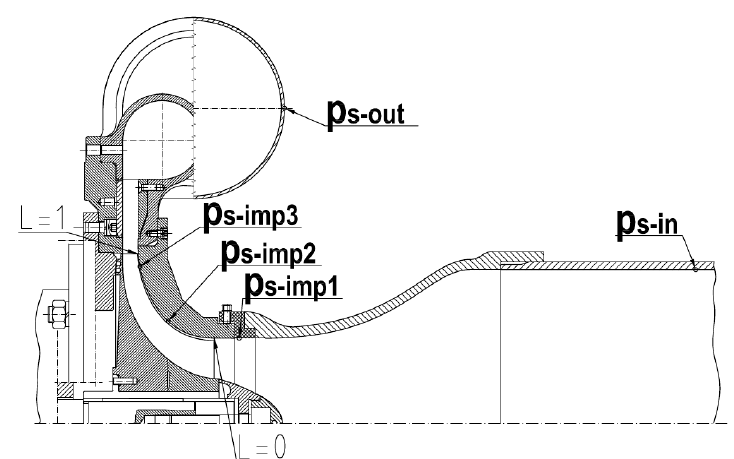
Figure 2: Cross-section of the DP1.12 blower used in this study with positions of the pressure gauges.